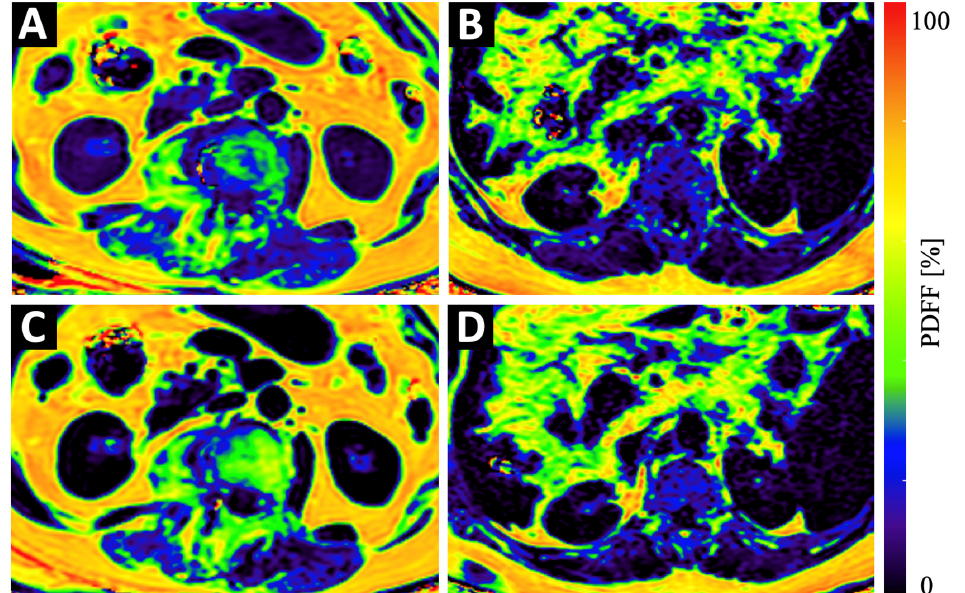
Figure 3. Example color-coded PDFF maps of a 84-year old osteopenic (BMD = 107 mg/cm 3 ) female patient ( A , C ) and a 69-year old male patient with normal BMD values (123 mg/cm 3 ) ( B , D ) at baseline ( A , B ) and 6 months follow-up ( C , D ). Although the maps of the osteopenic patient ( A , C ) show a strong increase in PDFF in vertebral bone and in the PSM, the increase in the maps of the non- osteopenic/osteoporotic patient ( B , D ) show only a very subtle increase in PDFF. In a further analysis, all patients were split into two equal-sized groups, depending on the baseline PDFF of the lumbar vertebrae (cut-off: 45.0%). In patients with a higher vertebral PDFF at baseline, the vertebral T2* value increase longitudinally over 6 months was significantly higher, compared to the T2* value increase in patients with lower vertebral PDFF at baseline (0.9 ± 1.6 ms vs. 0.0 ± 1.8 ms, p = 0.04) (Table 2). Moreover, when splitting the patients into two equal-sized groups, depending on the baseline PDFF of the PSM (cut-off: 4.00 %;), patients with higher baseline PSM PDFF showed a significantly higher increase in vertebral T2*, compared to those with lower baseline PSM PDFF (0.9 ± 2.0 ms vs. 0.0 ± 1.3 ms, p = 0.03). A further analysis showed that when splitting the patients into two equal-sized groups depending on the baseline vertebral T2* values (cut-off: 9.0 ms), change in vertebral PDFF was significantly greater longitudinally over 6 months in patients with higher baseline vertebral T2* values, compared to those with lower baseline vertebral T2* values (7.1 ± 10.1% vs. 0.8 ± 10.0%, p = 0.02) (Table 2). The intrareader (ICC, 0.979 [95% CI, 0.965–0.999]) agreement for BMD, as well as for T2* (ICC, 0.981 [95% CI, 0.968–0.999]) and for PDFF (ICC, 0.976 [95% CI, 0.959–0.999]) measurements were excellent.